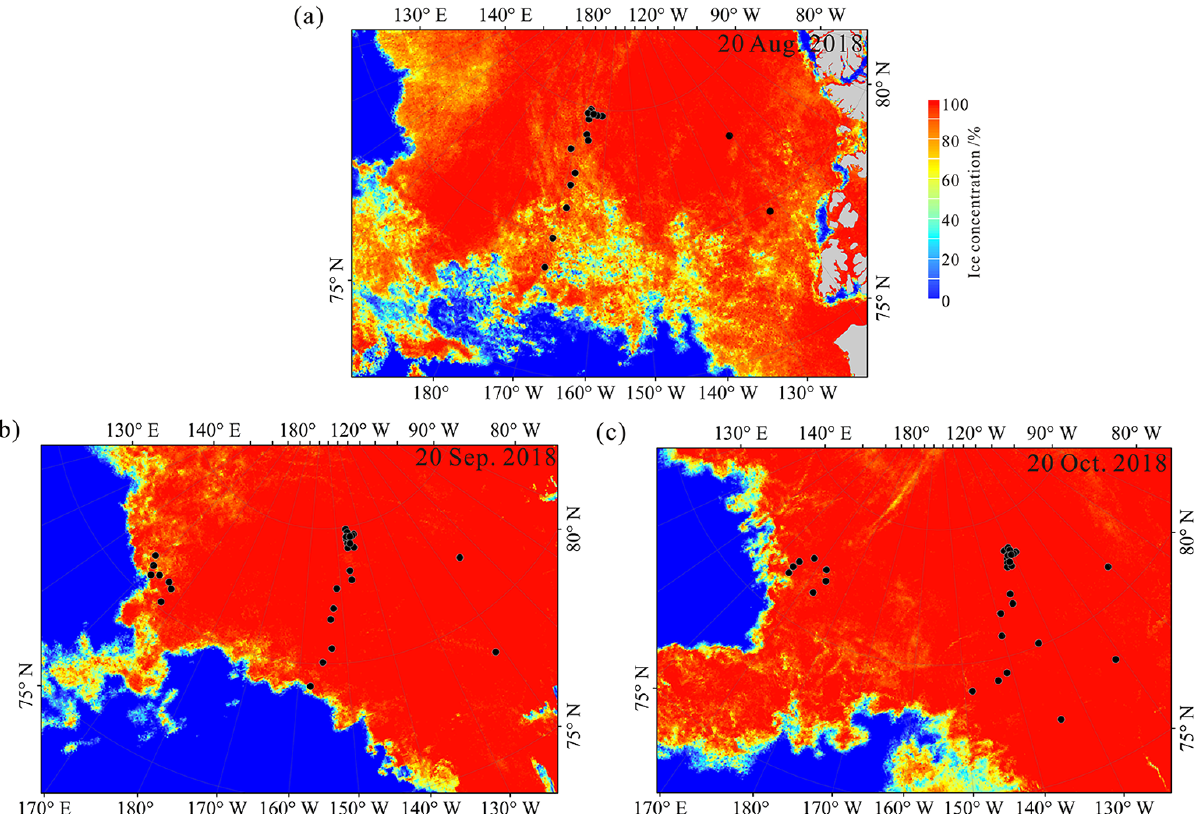
Figure 5. Sea ice concentration across the PAO on (a) 20 August, (b) 20 September, and (c) 20 October 2018, with black dots denoting buoy positions on the given